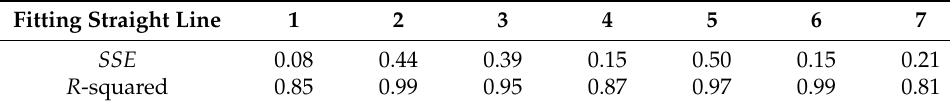
Figure 6. Fitting results. Table 3. Parameters of fitting straight line.